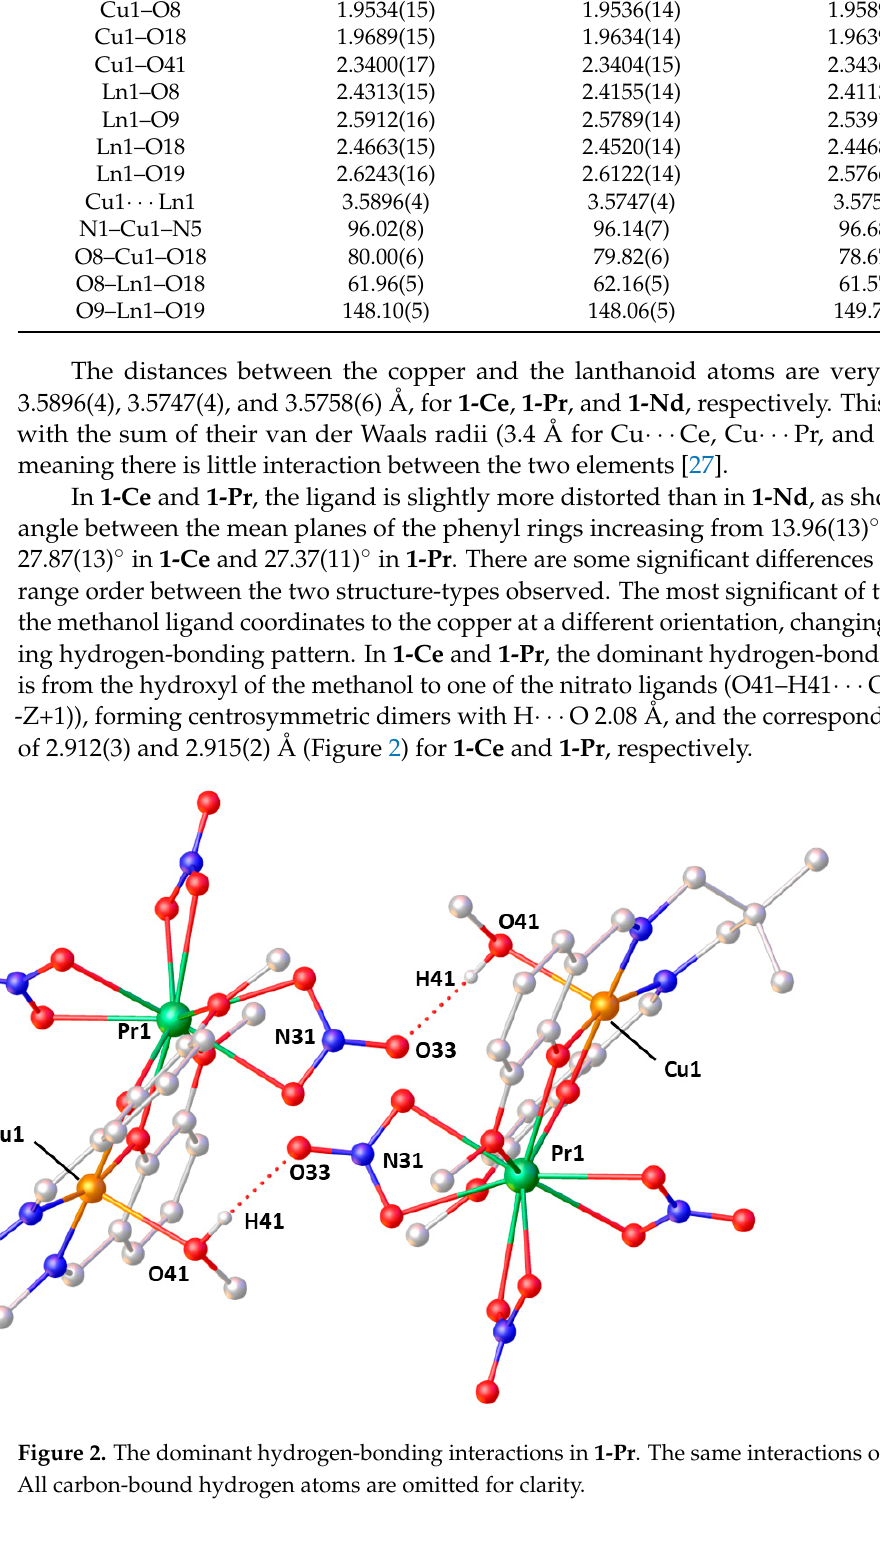
Table 1. Selected bond lengths (Å) and angles (degrees) for compounds 1-Ce , 1-Pr , and 1-Nd .